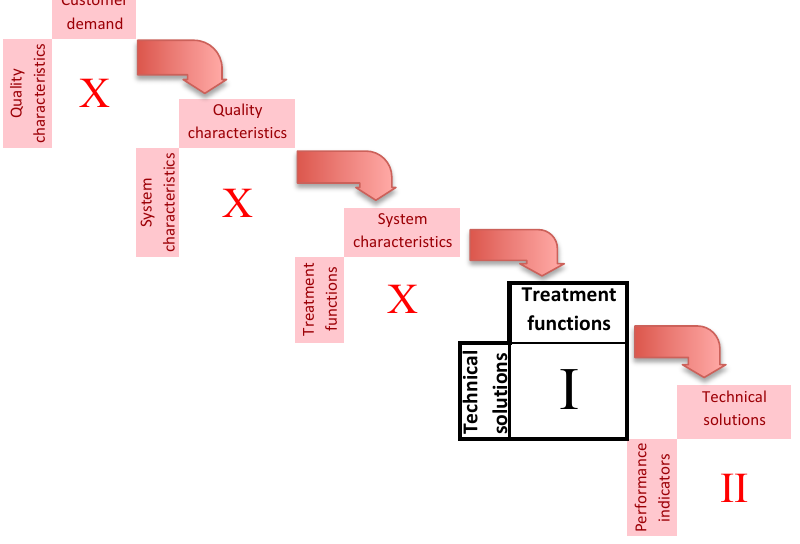
Figure 1. Quality function deployment (QFD) matrix